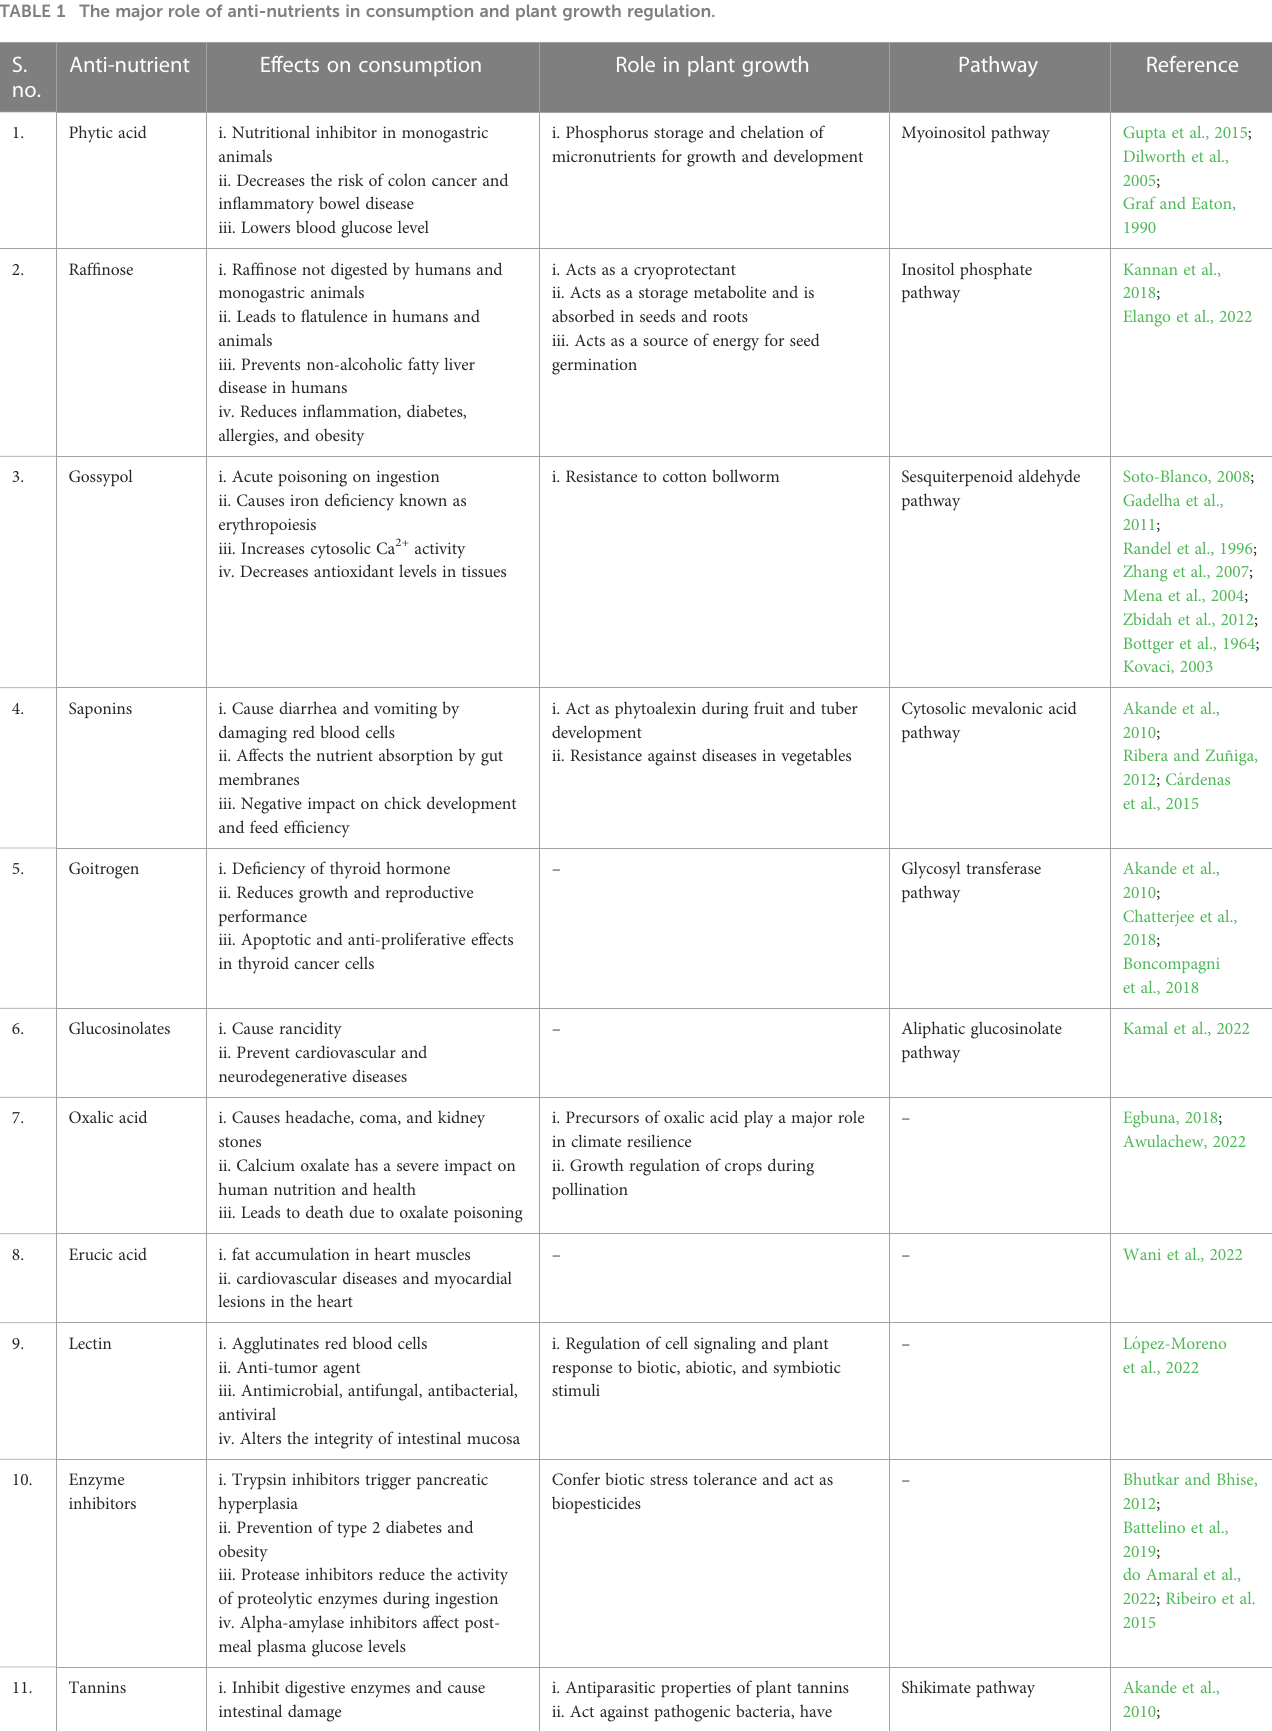
TABLE 1 The major role of anti-nutrients in consumption and plant growth regulation. S.